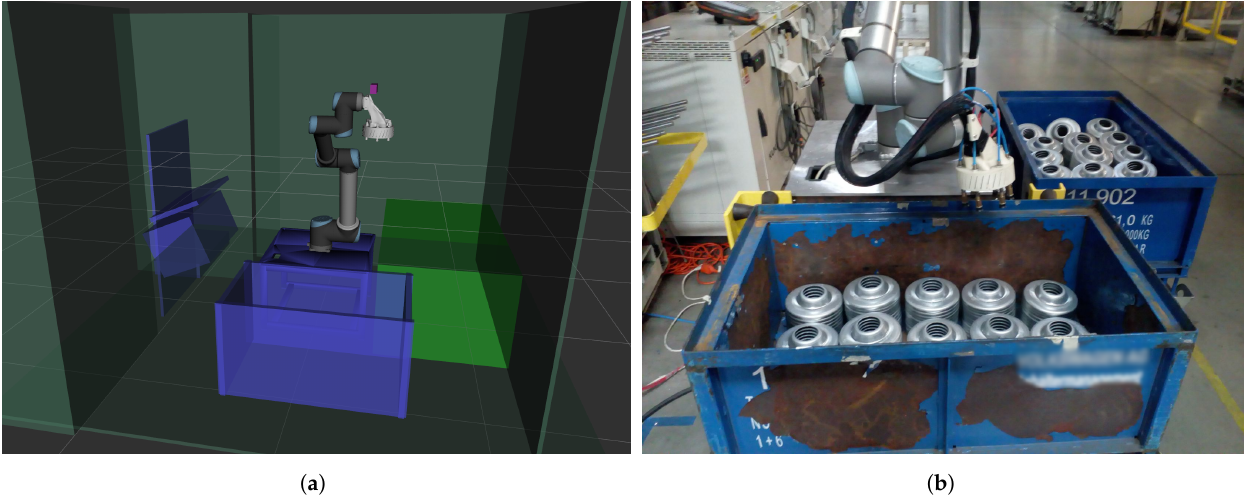
Figure 17. Robotic work cell. ( a ) The model of the robotic workspace created in MoveIt libraries. ( b ) The setup of the robotic cell in the